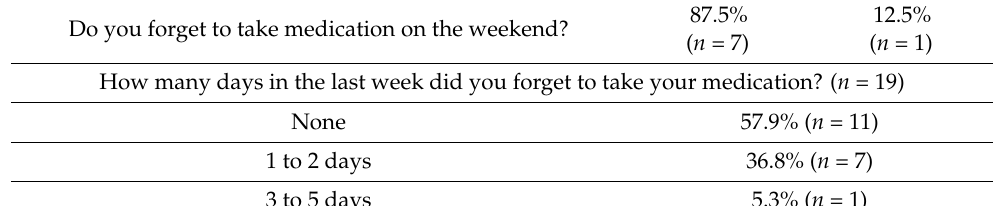
48.7% 51.3% ( n = 19) ( n = 20) 42.1% 57.9% ( n = 8) ( n = 11)